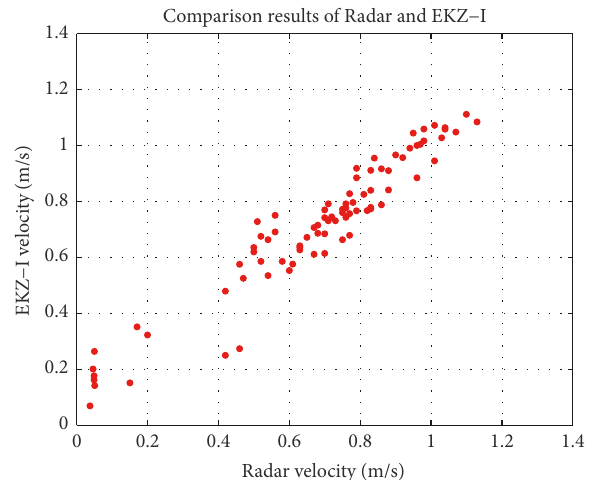
Figure 15: 2016-7-15 to 2016-7-30, 9 comparisons of the results between EKZ-I and OSMAR-SU.